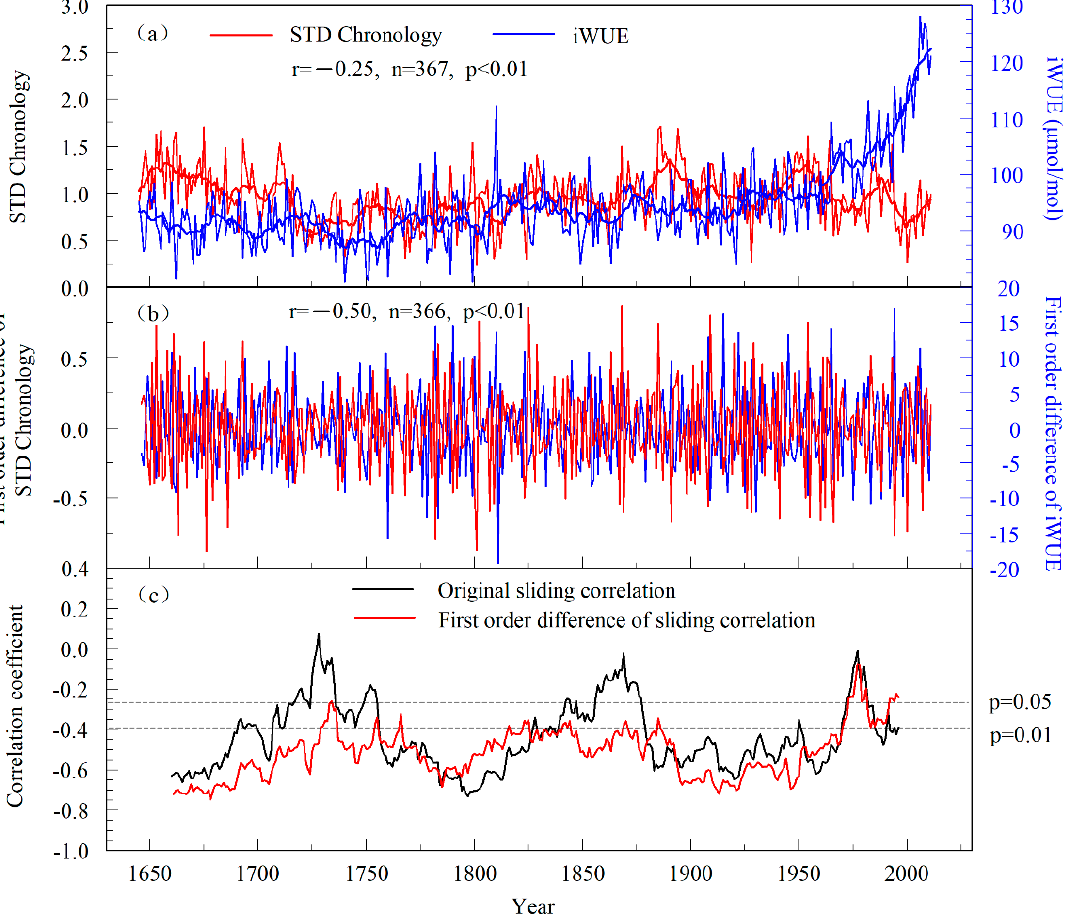
Figure 8. ( a ) Comparisons between the iWUE and the tree ‐ ring STD chronology (the thick line is an 11 ‐ year moving average series), ( b ) first ‐ order difference series, and ( c ) the 31 ‐ year sliding correlations between the tree ‐ ring STD chronology and the iWUE series in Mt. Shimen.